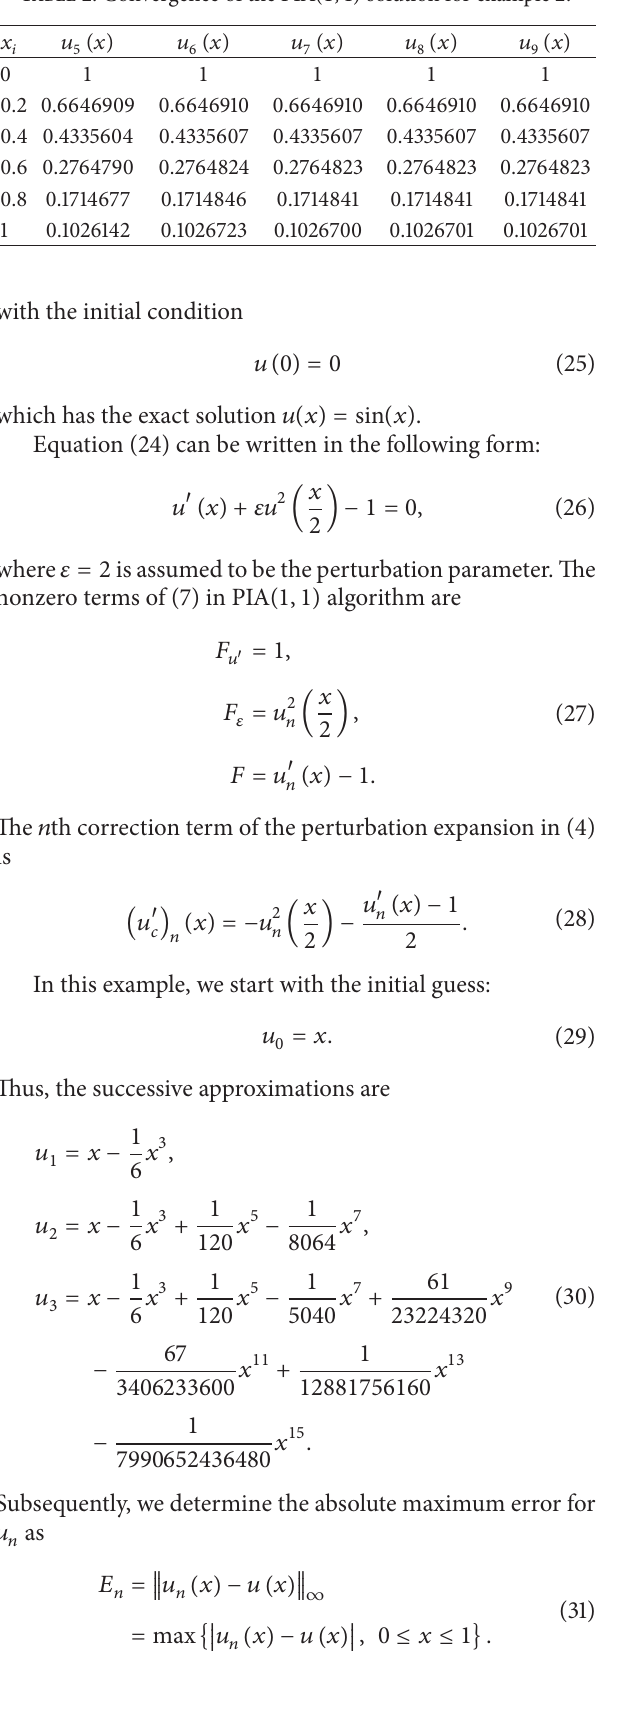
Table 2: Convergence of the PIA (1,1) solution for example 2 .